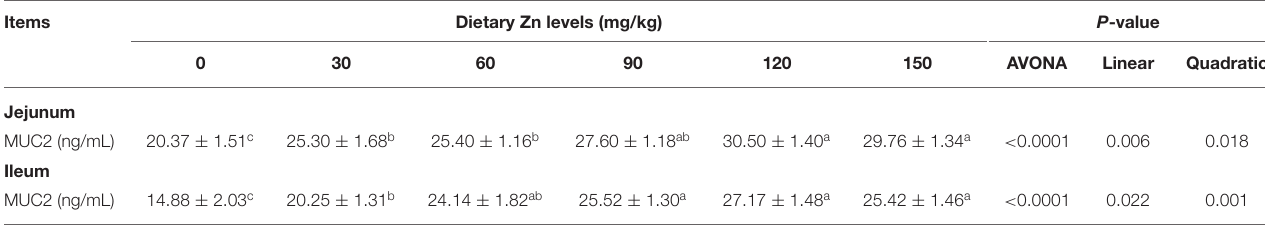
TABLE 6 | Effect of dietary Zn-Met on intestinal mucin content of ducks. Items Dietary Zn levels (mg/kg)